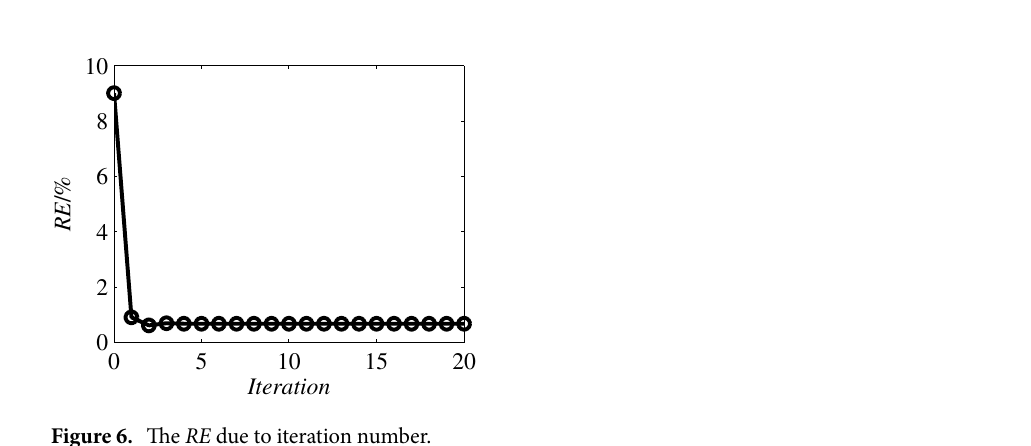
Figure 5. The RE versus RMS noise with θ of 30 ( a ), 120 ( b ), 210 ( c ) and 300 ( d ) degree.